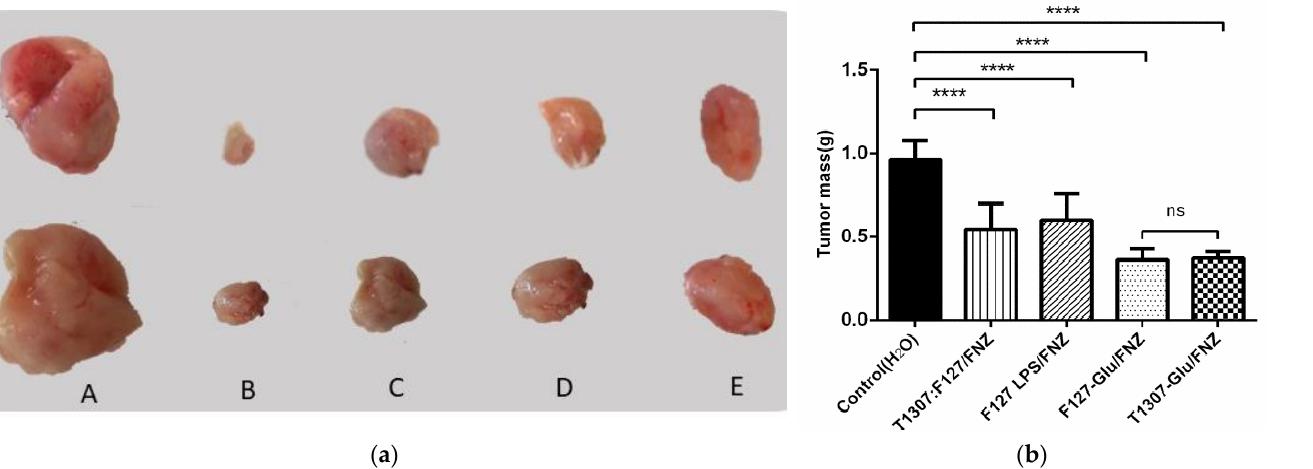
Figure 6. Animal survival in the different treatments ( n = 6). The comparative analysis of the curves was carried out from the Kaplan-Meier analysis with the non-parametric log-rank test with a p < 0.05 (0.036), X 2 > 3.84 (6.818) already described in experimental. **** Statistically very significant reduction in survival between T1307:F127/FNZ and T1307-Glu/FNZ with respect to T1307:F127/FNZ and F127:LPS/FNZ.